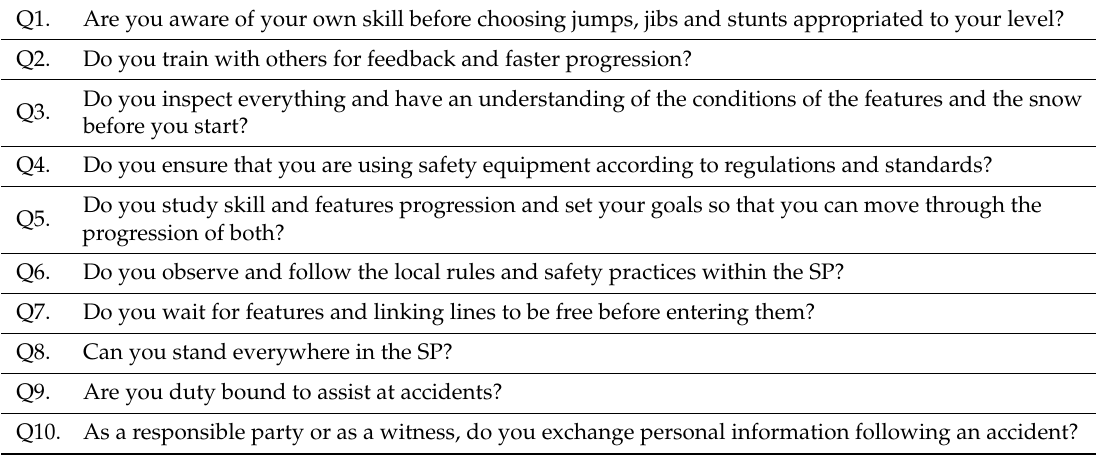
Table 2. Passive knowledge: intuitive behavior for given situations in the snow parks